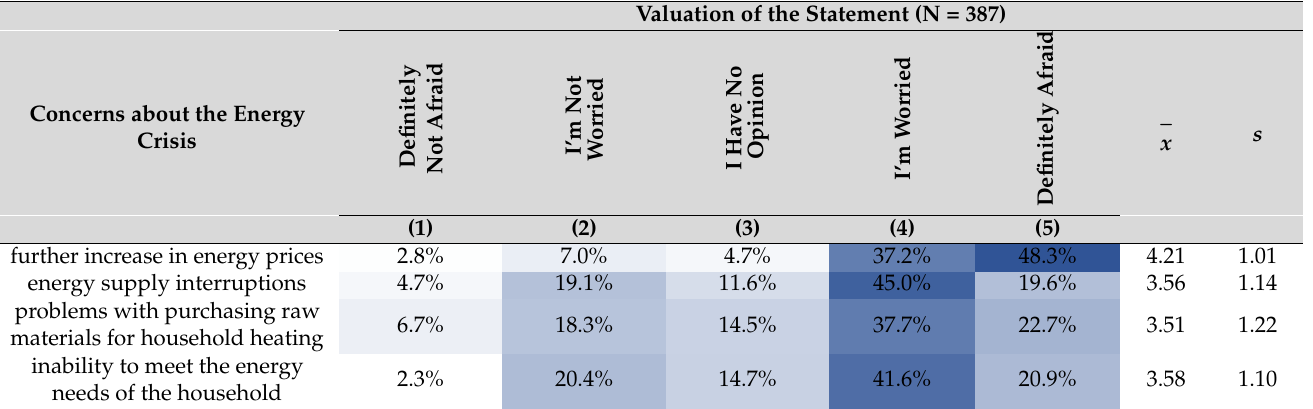
Table 6. Assessment of concerns about the energy crisis—response structure and basic statistical parameters.